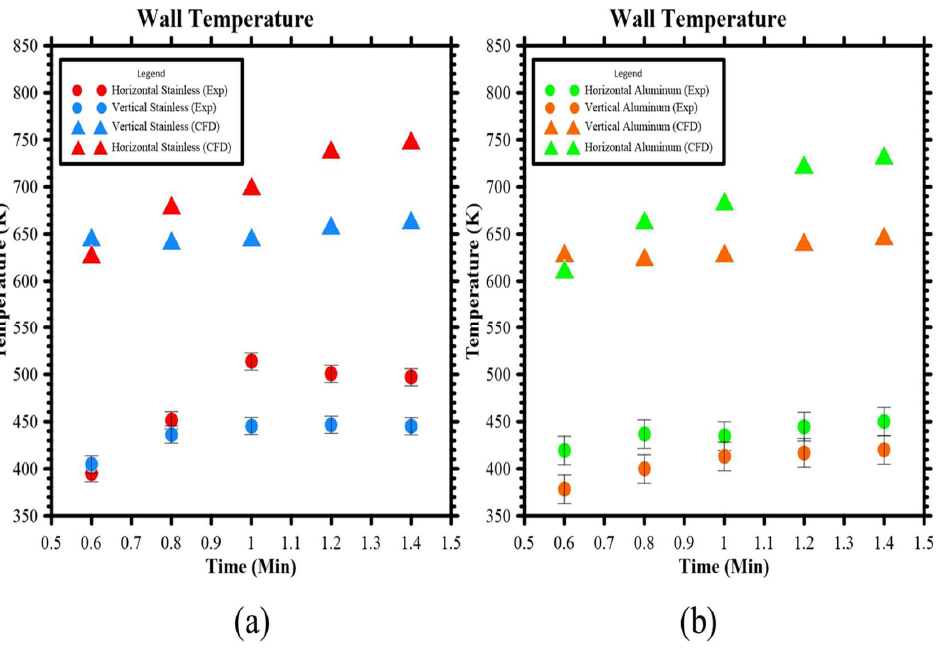
Figure 17. Wall temperature measurements for ( a ) stainless steel and ( b ) aluminum combustors .